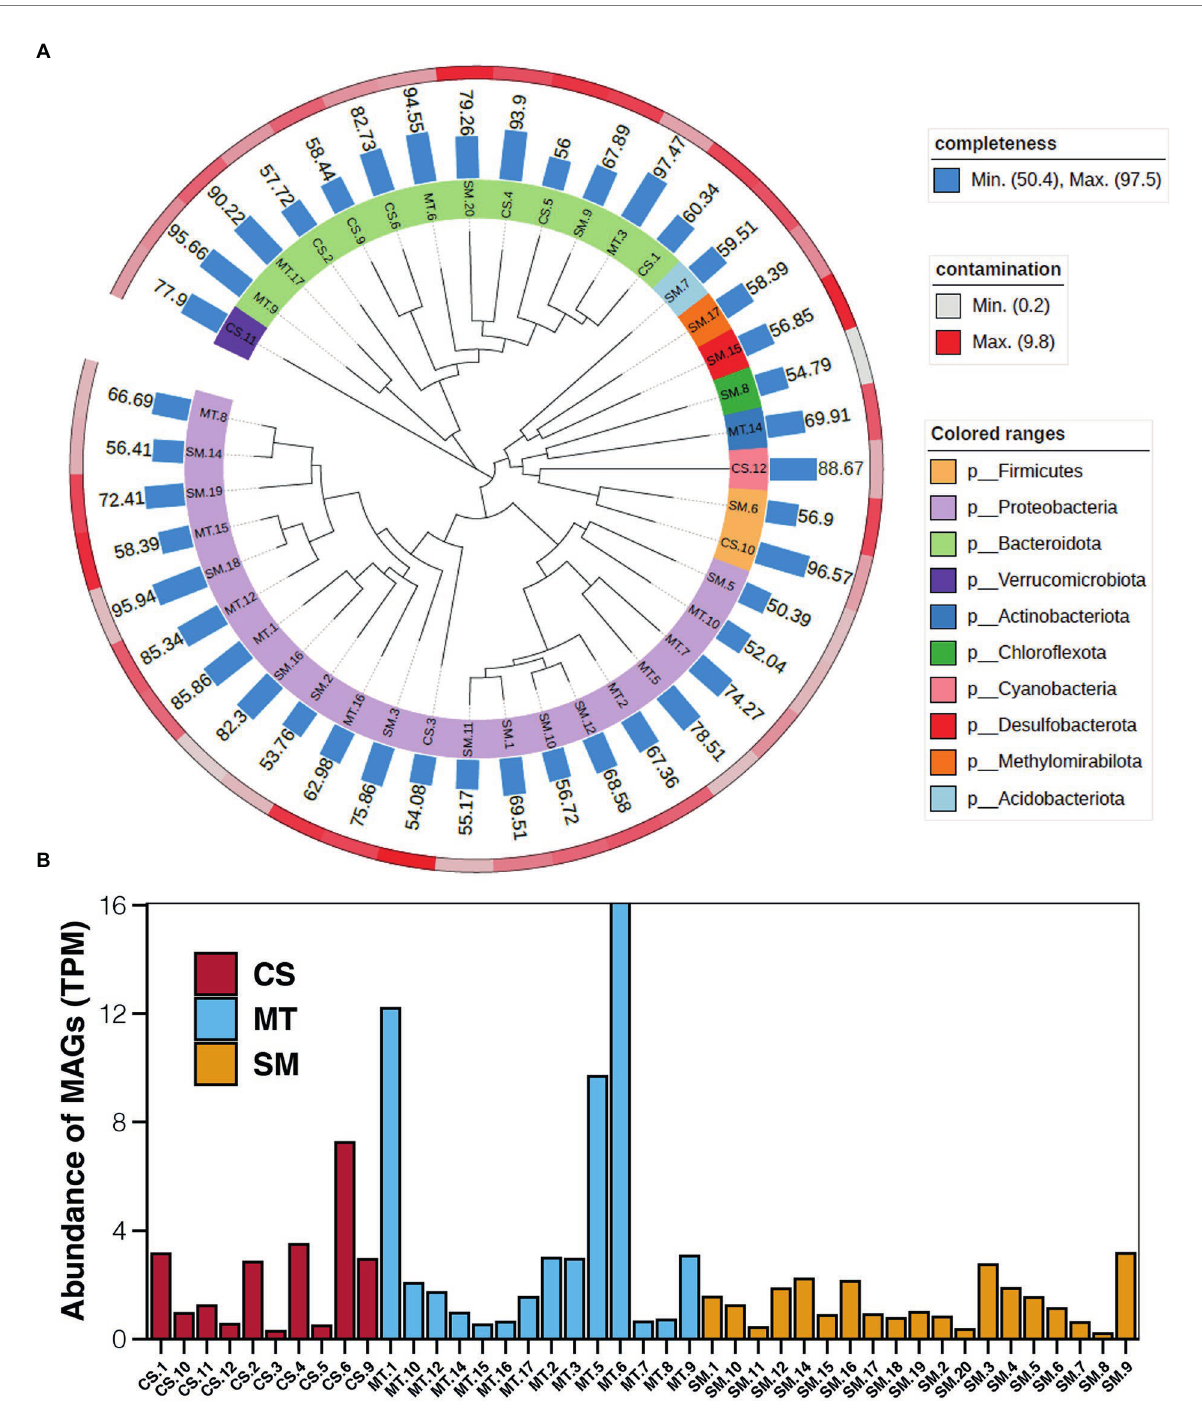
FIGURE 5 (A) Maximum-likelihood phylogenetic tree showing the affiliation, completeness, and contamination of retrieved MAGs. (B) Abundance of MAGs in sediments from CS, MT, and SM. The unit of MAG abundance is TPM, the average read coverage of a bin per million mapped